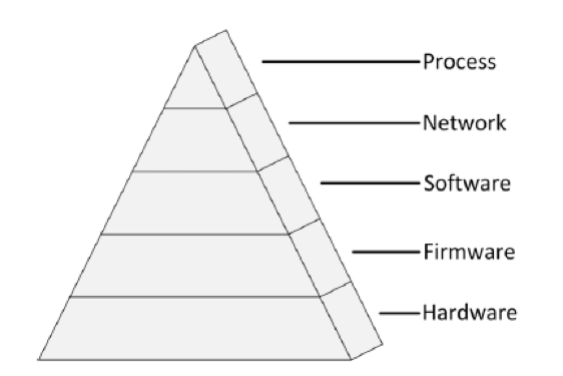
Figure 2. Model of the Architecture Layers of an Industrial Control System (ICS)